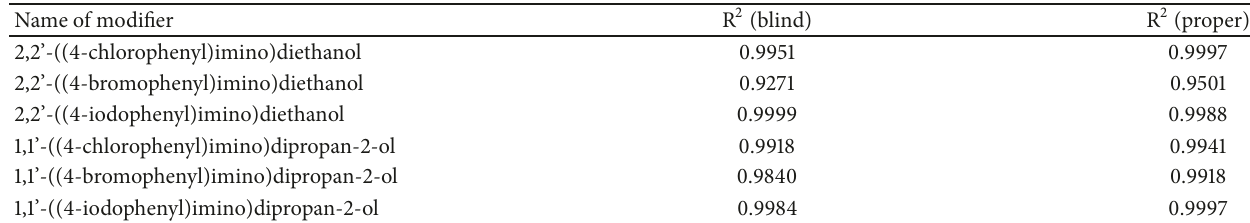
Figure 1: Absorbance in function of wavelength for selected modifier (red thick curves, blind samples). Table 1: Values of R 2 for linear fitted